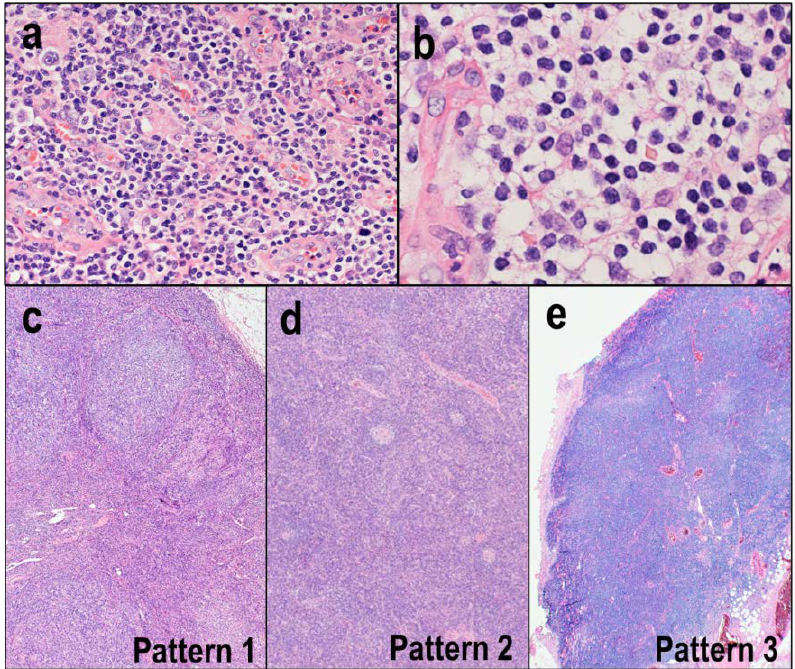
Figure 2. Angioimmunoblastic T-cell lymphoma. ( a ) Lymph nodes are characterized by partial